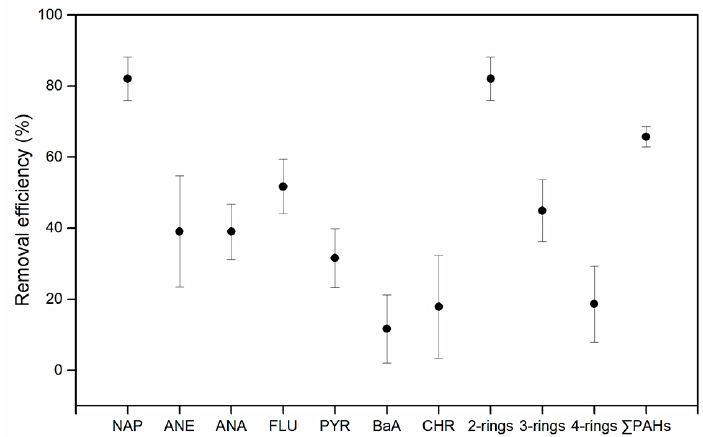
Figure 3. The removal efficiencies of PAHs in the dissolved phase. Error bars represent 1 standard deviation of the mean.